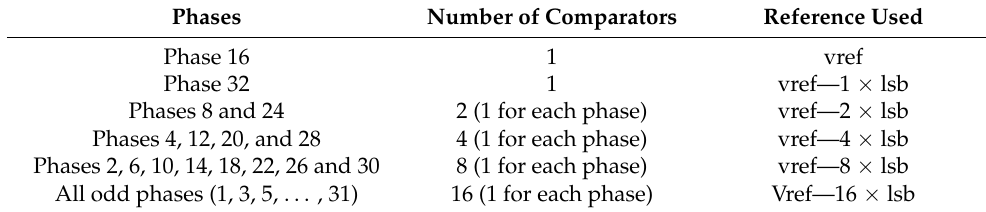
Table 1. Comparators phase